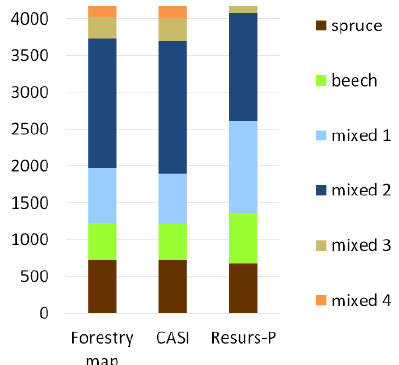
Figure 8. Distribution of forest classes in forestry map, and in CASI and Resurs-P classification result (mixed 1 - 50 % spruce, 50 % beech; mixed 2 - 70 % spruce, 30 % beech; mixed 3 - 30% spruce, 70 % beech; mixed 4 - spruce 70%, pine 30